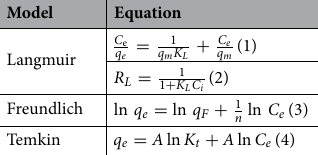
Table 1. Adsorption isotherm models for MO dye removal using HNTs and ChNTs 59,60 .